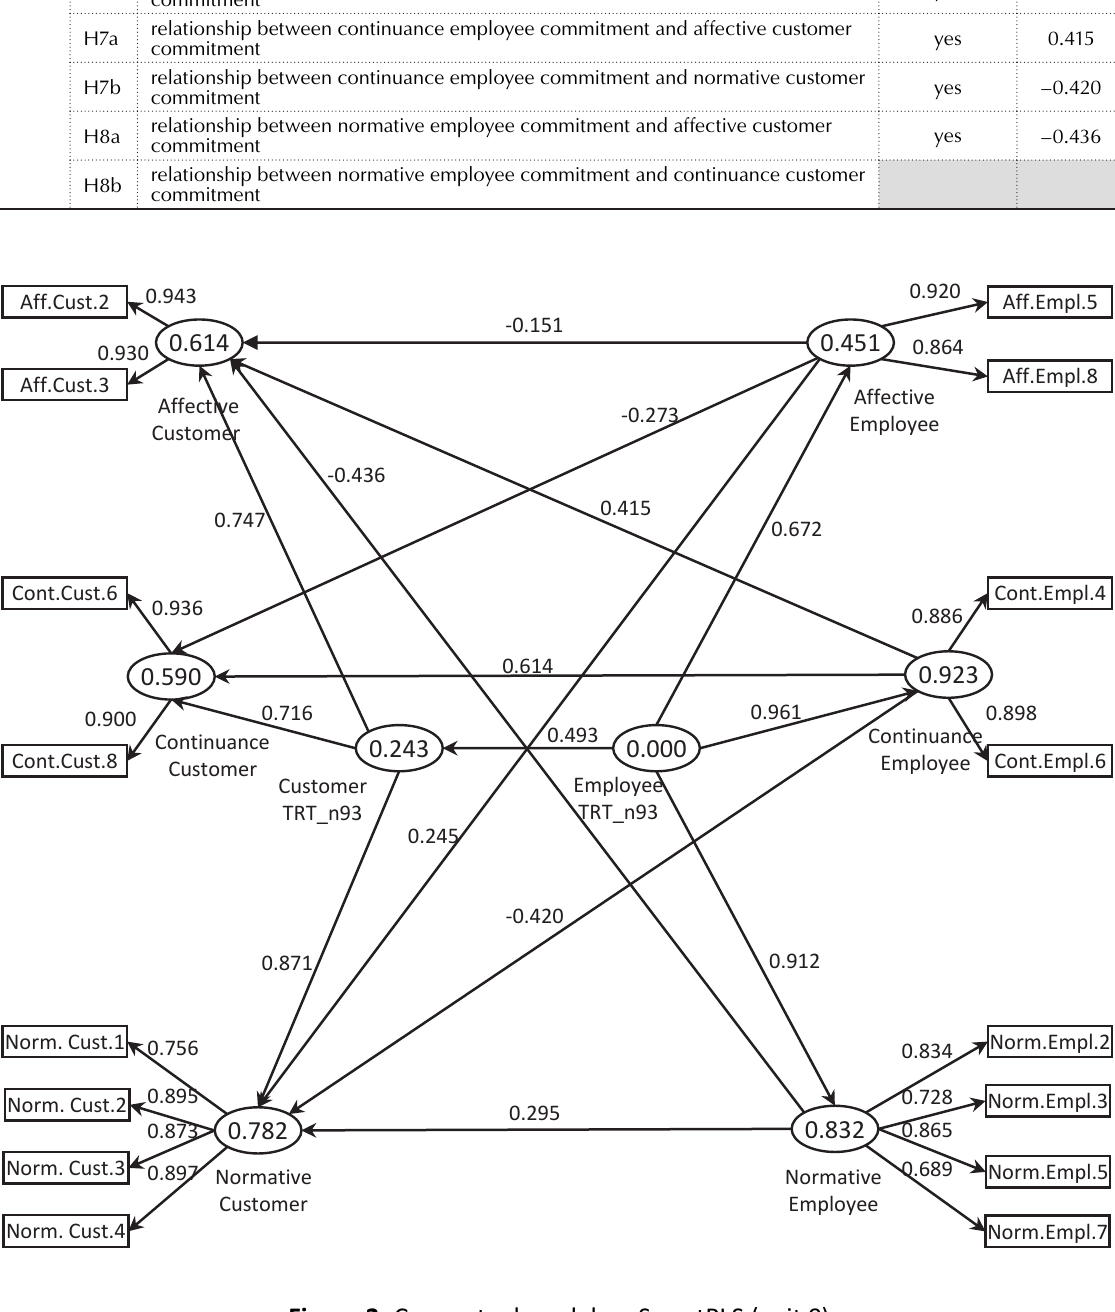
Figure 2. Conceptual model on SmartPLS (unit